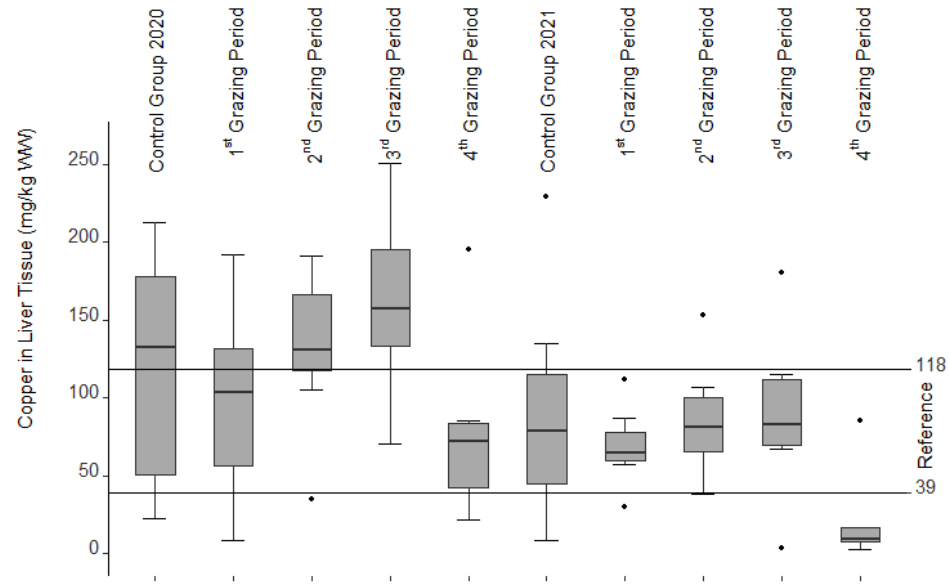
Figure 5. Copper content of fresh liver tissue (wet weight (WW)) after slaughter. Please note the statistical nine single statistical outliers.